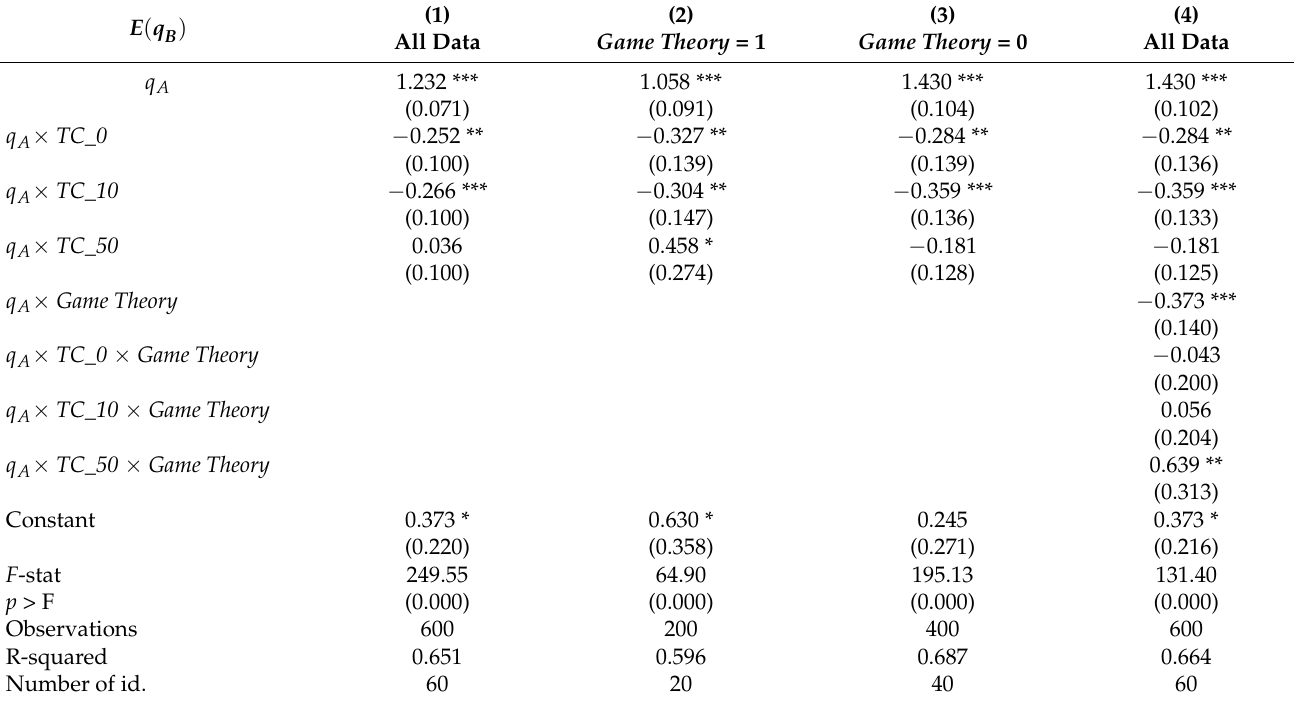
Table 3. Trustor’s expectations of trustee’s